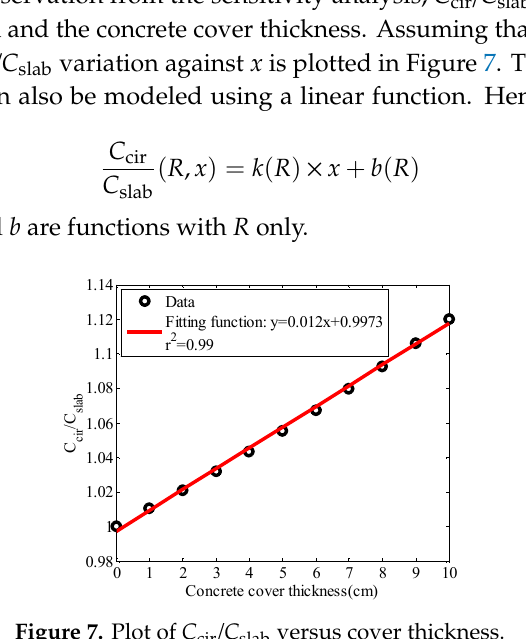
Figure 7. Plot of C cir / C slab versus cover thickness.